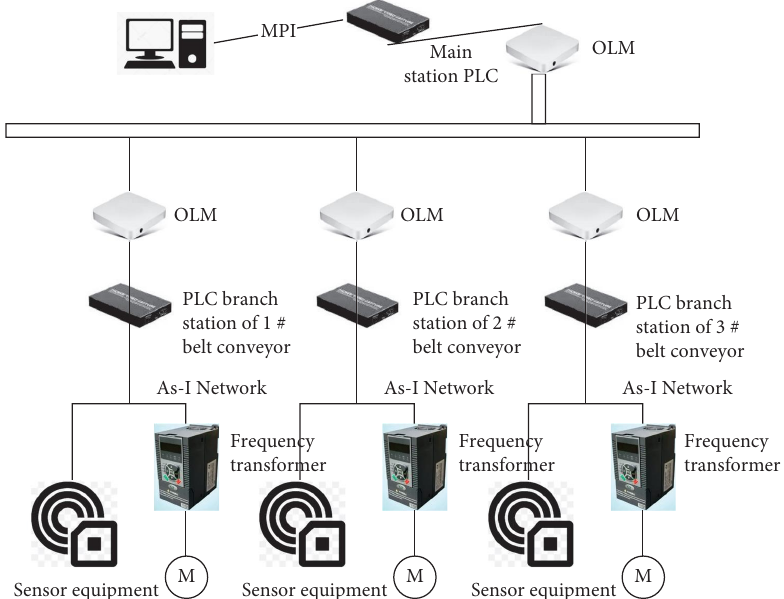
Figure 5: Comparison before and after removing the loading phase. (a) Comparison before and after removing the loading phase S Comparison before and after removing the loading phase S 21 .